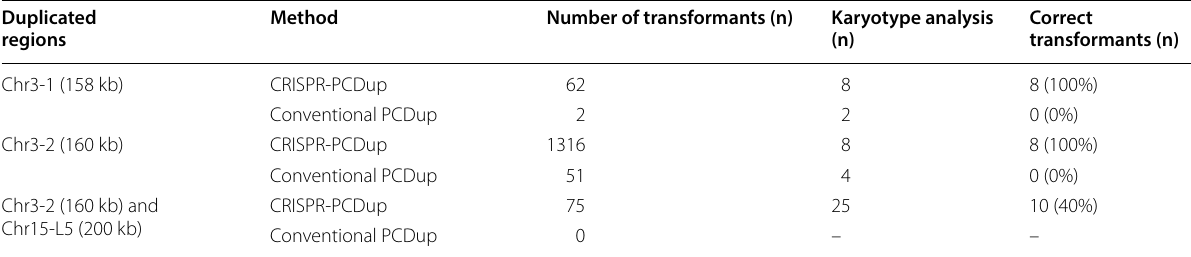
Symbol “–” indicates that karyotype analysis and counting the number of correct transformants were not applicable